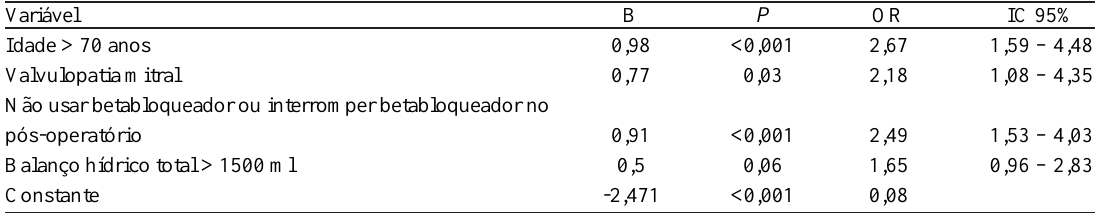
Tabela 2. Fatores de risco definidos como de alta associação com FA pós-operatória por meio de modelo de regressão logística